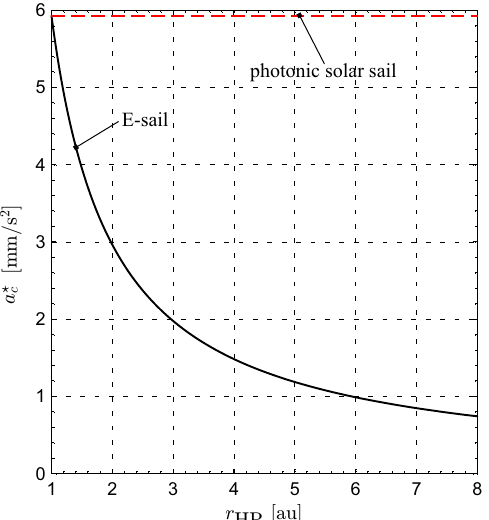
Figure 3. Characteristic acceleration necessary for a spacecraft to maintain an HP as a function of its solar distance r HP ; see also Equation